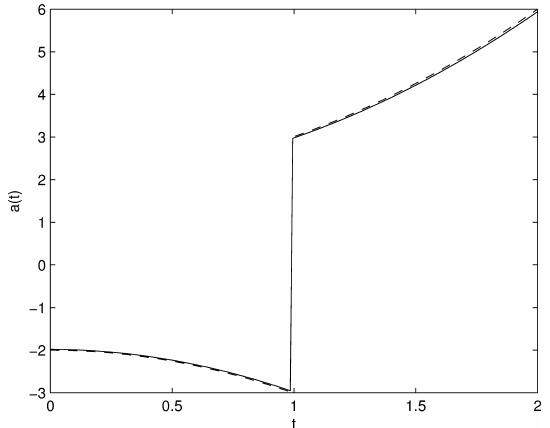
Fig. 5. The analytical and numerical solutions of a.t/ when T D 2 The analytical solution is shown with dashed